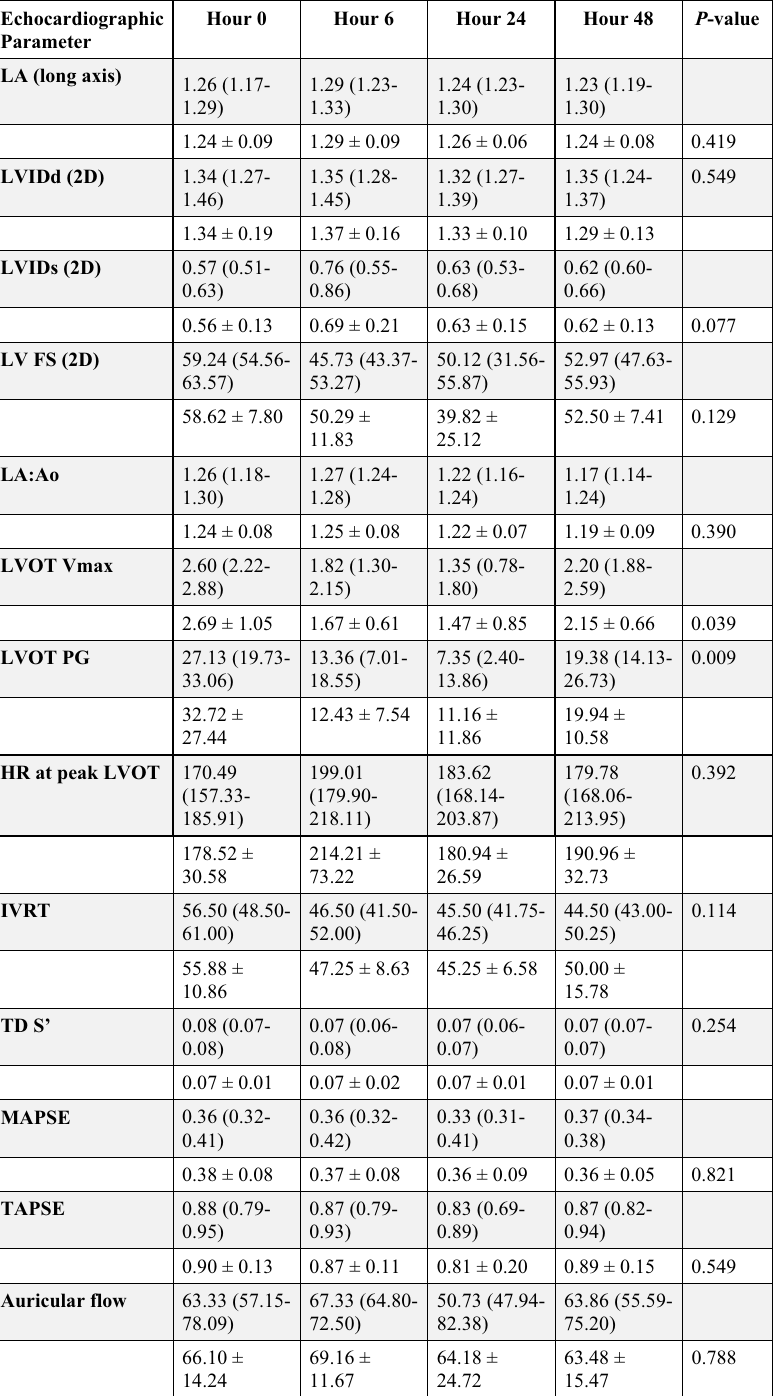
Table 3. Treatment group B: 0.3 mg/kg. Echocardiographic variables for the 0.3 mg/kg aficamten treatment group with reported mean ± standard deviation (unshaded rows) and median and interquartile range (shaded rows). The P value for variables that were statistically evaluated by either repeated measures one-way ANOVA or Friedman’s test are shown. LA left atrium, LVIDd left ventricular internal dimensions (diastole), LVIDs left ventricular internal dimensions (systole), LV left ventricle, FS fractional shortening, LVIDd left ventricular internal diameter (diastole), LVIDs left ventricular internal diameter (systole), LA/Ao left atrial-to-aortic root ratio, LVOT left ventricular outflow tract, Vmax velocity (maximum), PG pressure gradient, HR heart rate, IVRT isovolumic relaxation time, TD tissue Doppler, S’ mitral annular systolic velocity, MAPSE mitral annular plane systolic excursion, TAPSE tricuspid annular plane systolic